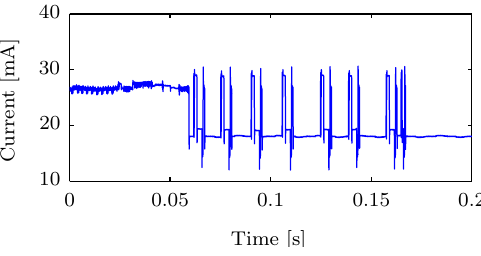
Figure 11. The figure shows the current consumed during transmission of an IPv6 packet. The 6LoWPAN fragmentation of the IPv6 packet is clearly visible. The IPv6 packet is divided into 8 6LoWPAN